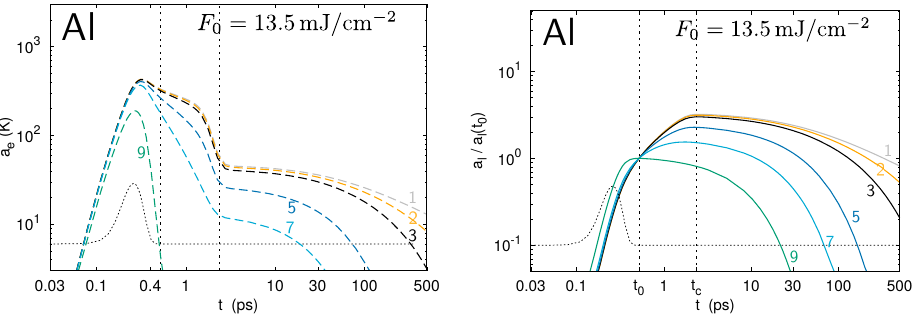
Figure 4. Evolution of the amplitudes a e ( left ) and a l ( right ) of the perturbation in the electron and lattice temperatures, respectively, at the surface of gold upon irradiation by a single laser pulse. Each curve corresponds to a different spatial period Λ in the modulation of the transverse intensity (see numbering in Table 2). For the lattice temperature, the amplitude is normalized to its value at t 0 : we plot a l ( t ) /a l ( t 0 ) .